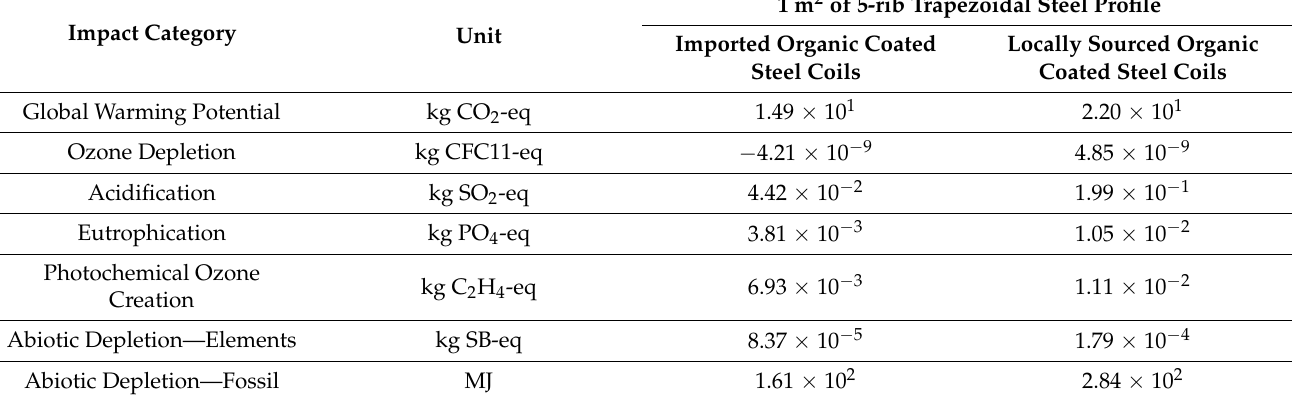
Table 2. Comparison of the life cycle impacts of the imported and locally sourced organic coated steels.